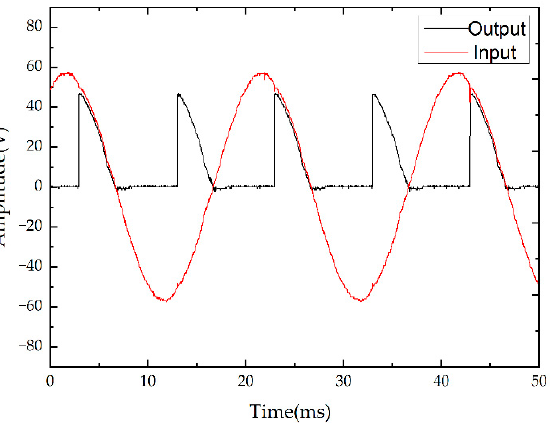
Figure 8. The trends of the conduction angle of the MT2DC with the control signal of the main control circuit board.